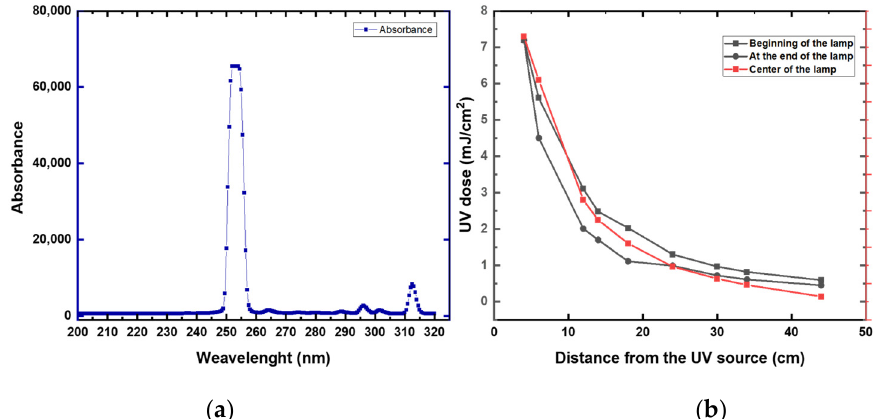
Figure 6. ( a ) UV intensity at different distances from the UV lamp and at different locations of the UV lamp. ( b ) UV spectrum of the studied UV lamp. UV lamp. ( b ) UV spectrum of the studied UV